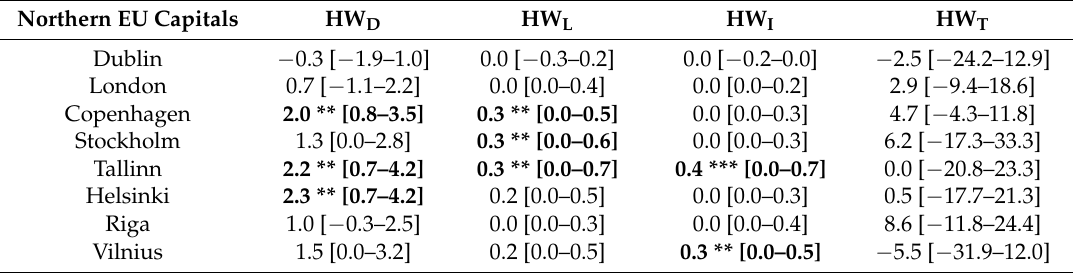
Table 1. Trend slopes (5-year change), statistically significant changes and 95% confidence interval (square brackets) of the heatwave hazard characteristics (HW D : heatwave days; HW L : long heatwaves; HW I : high-intensity heatwaves; HW T : the timing of the first simultaneously long and high-intensity heatwave) in northern EU capitals. Significant trends are shown in